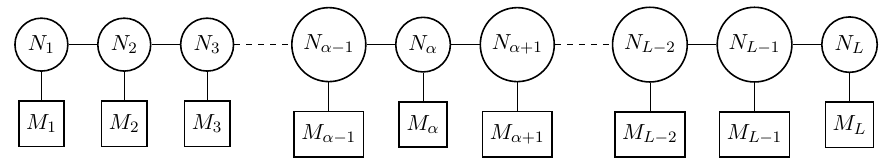
Figure 3 . A generic linear quiver with L gauge nodes.